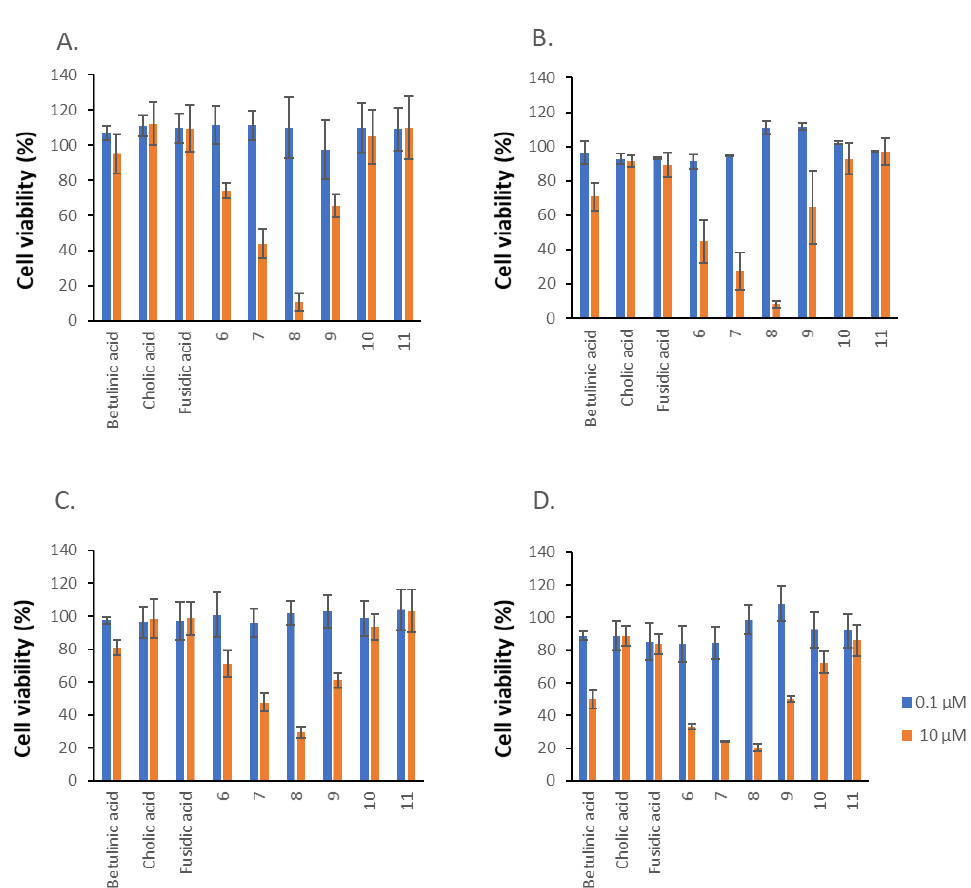
Figure 3. Cell viability of HT29 ( A , B ) and PC3 ( C , D ); cell lines were treated by the investigated compounds for 48 h. Cell viability was determined using CV assay ( A , C ) and MTT assay ( B , D ). Table 1. IC 50 values ( μ M) for the most active compounds against HT29 and PC3 cell lines deter- mined by MTT and CV assays.